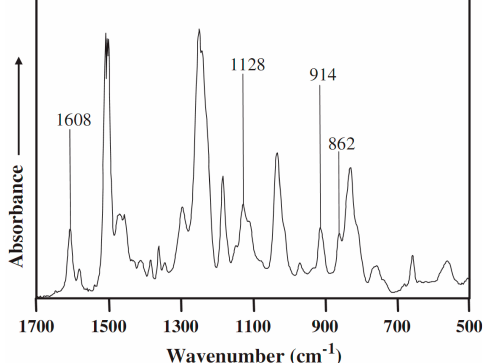
Figure 3. FT-IR-spectrum of non-cross-linked SU-8 showing the epoxide peak at 914 cm − 1 associated with cross-linking of SU-8 and the peak of the aromatic C-C stretch mode at 1608 cm − 1 used as reference